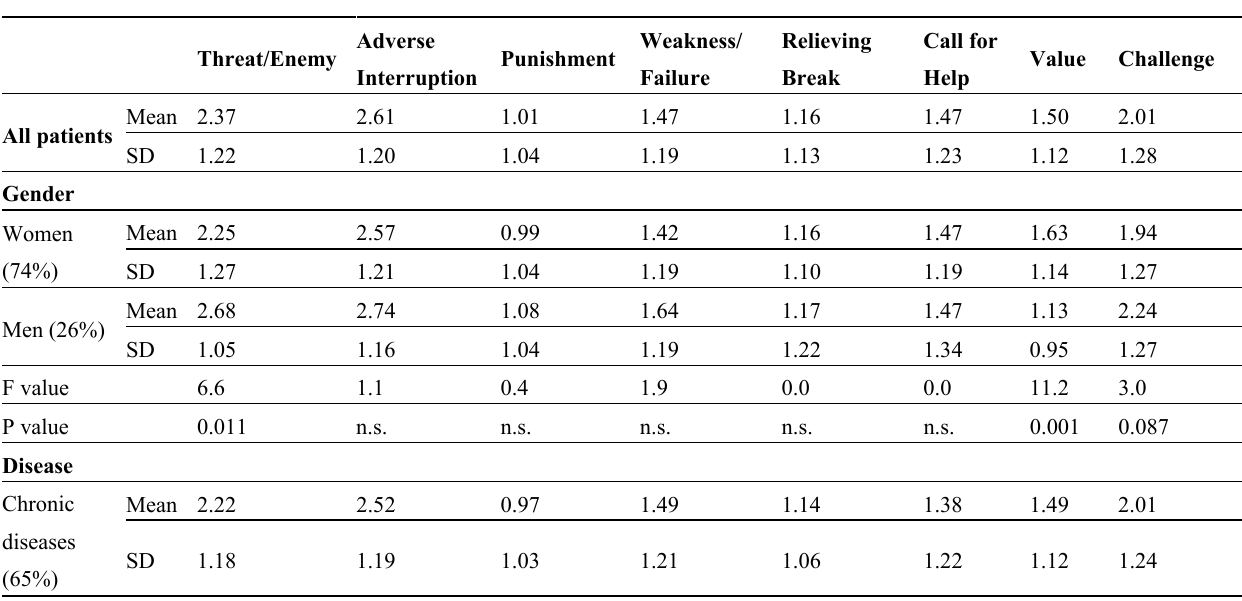
Table 4. Interpretations of illness and socio-demographic